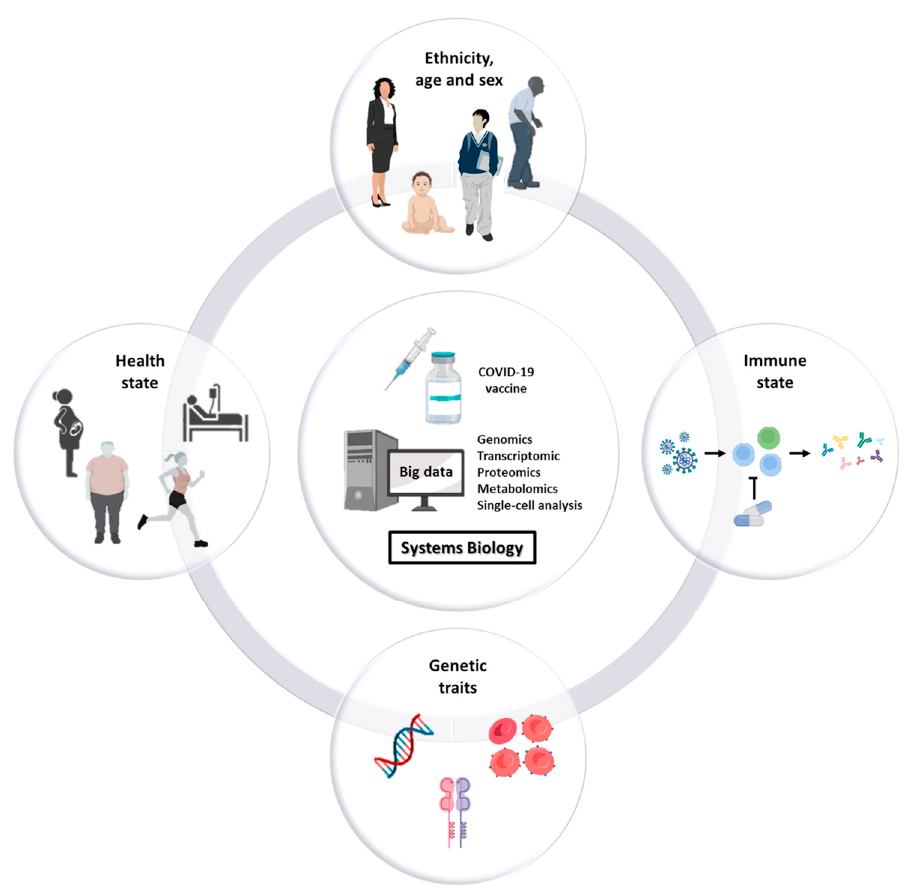
Figure 1. Factors influencing the efficacy and safety of vaccines. Studies show that responsiveness as well as potential adverse reactions to vaccines are dependent on several factors including sex, age, ethnicity, comorbidities, immune state, therapies, and the genetic/biological characteristics of the individual. Systems biology is instrumental to differentiate the cohorts of subjects that will benefit from vaccination from the ones that will not and may develop serious adverse effects after vaccination.